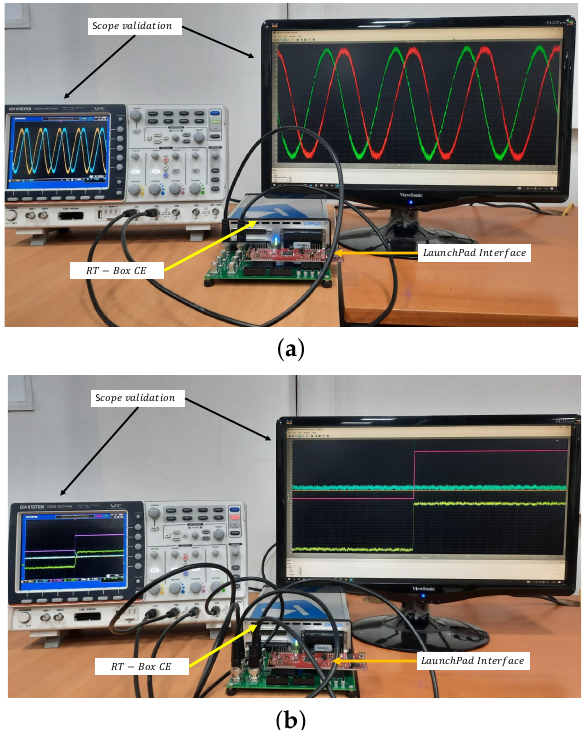
Figure 15. ( a ) Stator α − β currents HIL validation. ( b ) Torques from Minimum emission optimization algorithm HIL